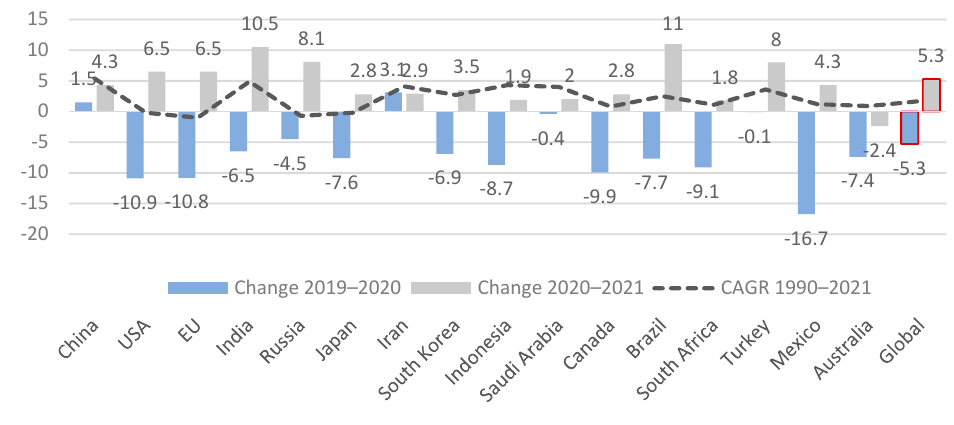
Figure 1. Dynamics of CO 2 emissions in selected countries in the periods 2019–2020, 2020–2021, from 1990–2021 (%).